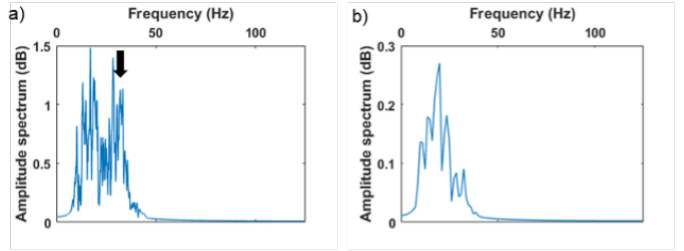
Figure 21. Frequency content of reflection responses with and without time windowing from a virtual source at the top geophone using check shot data. ( a ) Frequency content of Figure 15c, which is using a full time window of 30 s. ( b ) Frequency content of Figure 20c, which is using a time window selecting only the strong arrivals at 5.1–5.9 s. The arrow points to what could be the frequency content of the